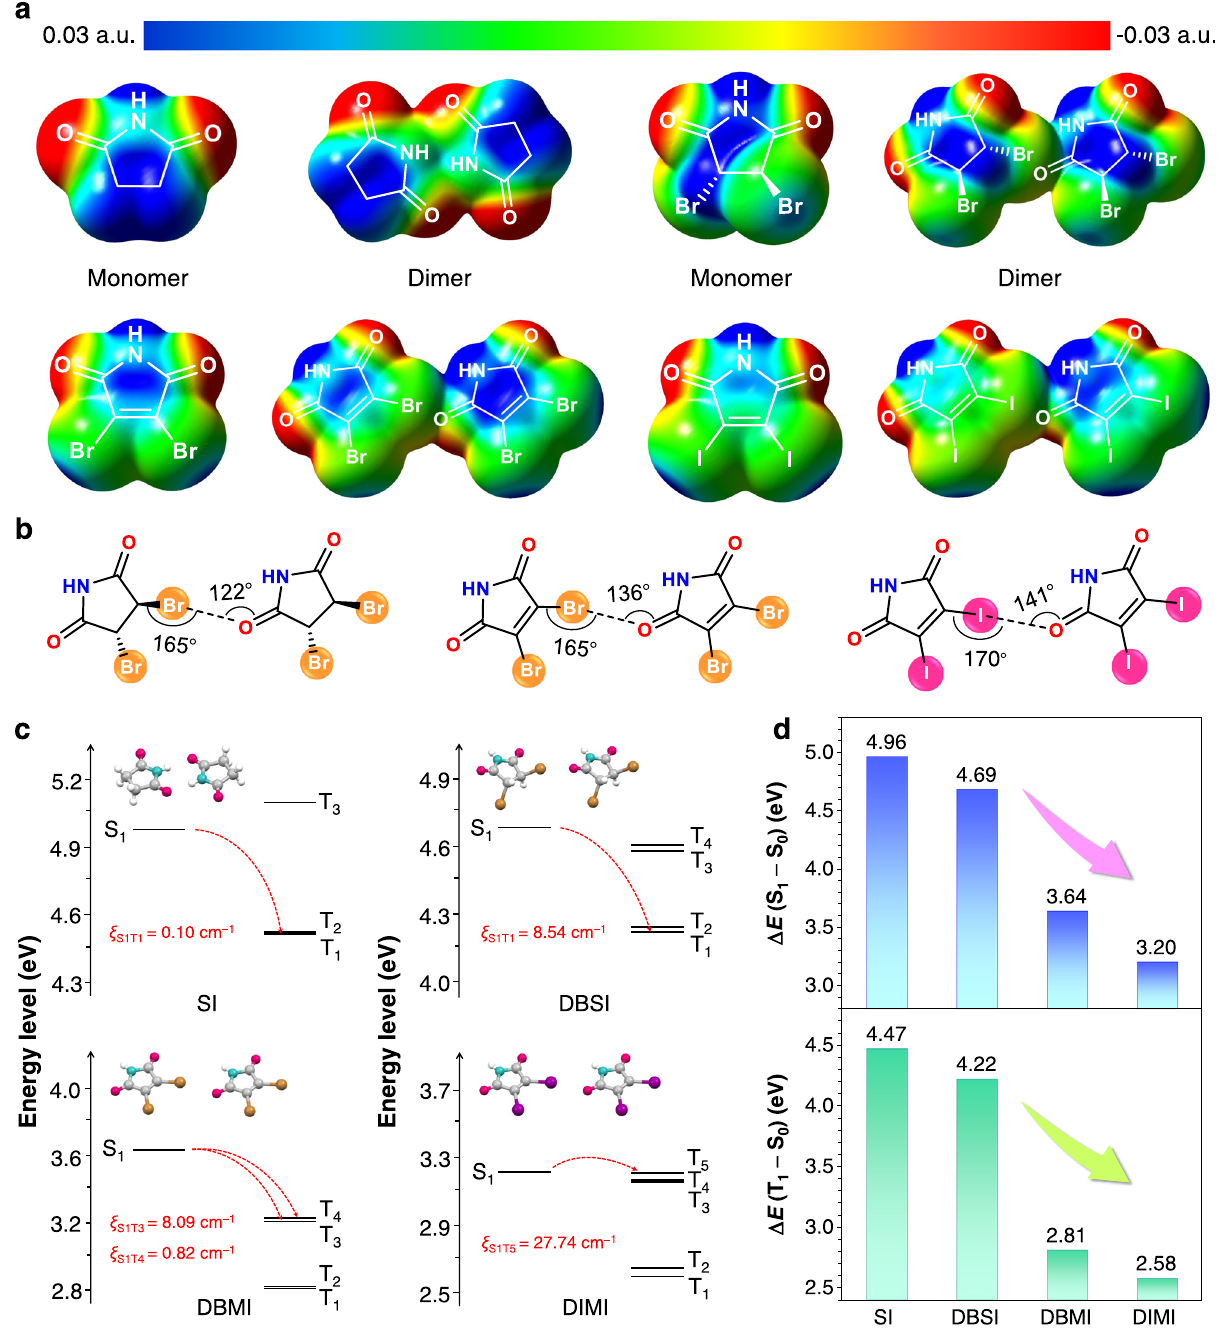
Fig. 4 Theoretical calculation of DBSI, DBMI, and DIMI. a Electric potential distributions of the excited states of monomers and dimers for varying compounds. b Illustration of the halogen contacts of DBSI, DBMI, and DIMI. c Energy levels of excited singlets and triplets of SI, DBSI, DBMI, and DIMI dimers. d Energy gaps of (S 1 – S 0 ) and (T 1 – S 0 ) for different dimers. S 0 is the ground state. S 1 and T 1 are the lowest singlet and triplet excited states. ζ represents the spin – orbit coupling